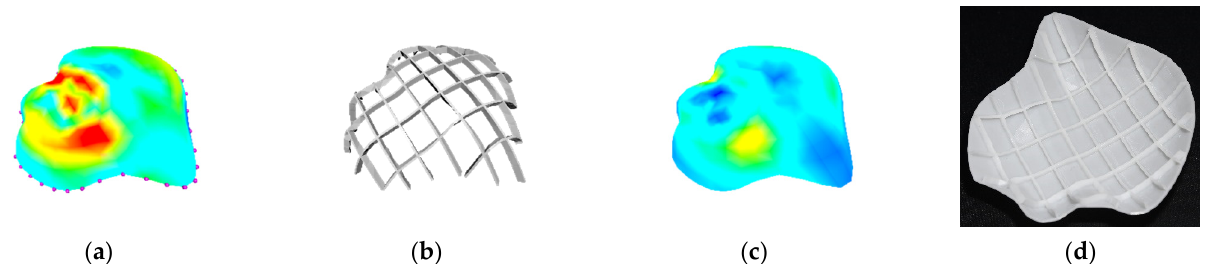
Figure 12. Bidirectionally stiffened botanic, from left to right: ( a ) initial stress without stiffeners, ( b ) optimized stiffeners, ( c ) final stress with stiffeners, ( d ) 3D print.